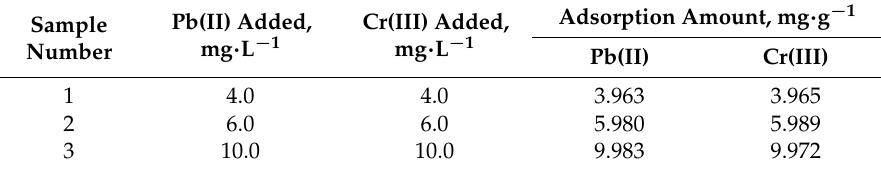
Table 5. Adsorptive removal of Pb(II) and Cr(III) from spiked real ground water collected from Yullyang-dong, Sangdang-gu, Cheongju-Si, Republic of Korea ( N = 3, mean values reported here, the